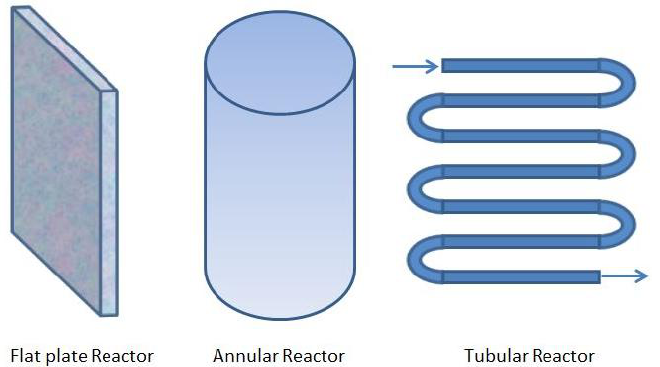
Figure 1. Commonly employed reactor